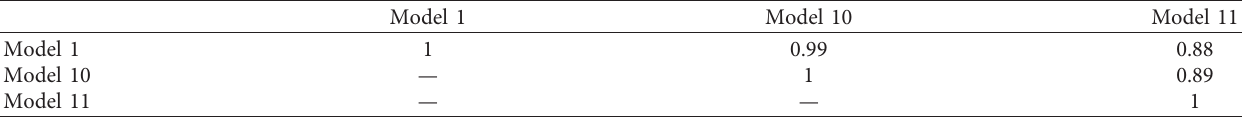
Table 24: Correlation of the ranks in the models 1, 10, and 11.